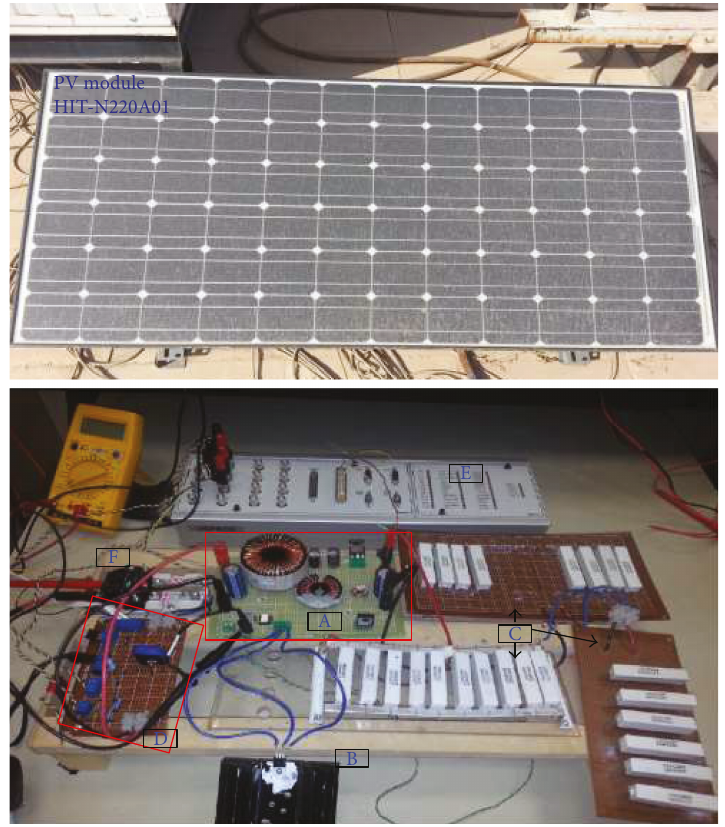
Figure 13: The hardware setup of the system. (a) DC-DC isolated Ć uk converter. (b) MOSFET model number IRFB4229 and its heat sink. (c) Resistive load bank. (d) Sensor board. (e) dSPACE 1104 board. (f) Input circuit breaker connected to the PV module.